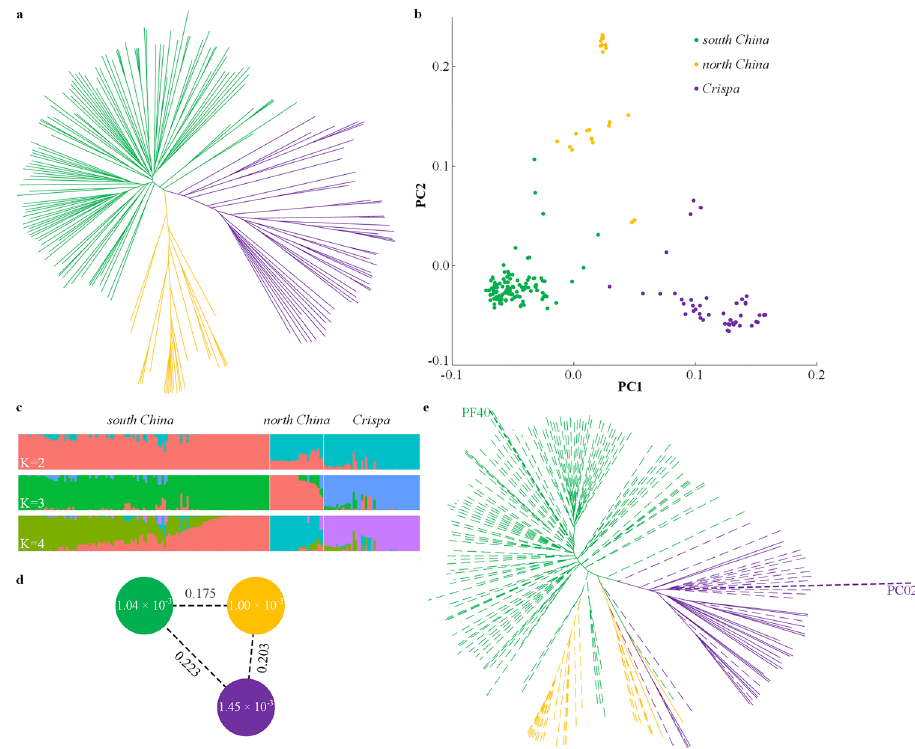
Fig. 4 Population analysis of perilla germplasms. a Neighbor-joining tree of 191 allotetraploid perilla accessions. Green, yellow, and purple branches indicated three perilla clades of south China ( n = 120), north China (26), and crispa (45), respectively. Totally 4,789,738 fi ltered high-quality SNPs were used for tree construction. b PCA analysis of these samples with the same SNP dataset. c Population structure of these samples based on different numbers of clusters ( K = 2 – 4). d Nucleotide diversity ( π ) and population divergence ( F ST ) across the three clades. The value in each circle indicates calculated nucleotide diversity for that clade, and the value along each line represents population divergence between two neighboring clades. e Neighbor- joining tree constructed with 108,850 PFA-speci fi c SNPs, and overlaid with leaf color information: dashed lines indicated green leaves, and solid lines represented red leaf phenotype. Color codes were the same in ( a ), ( b ), ( d ), and ( e